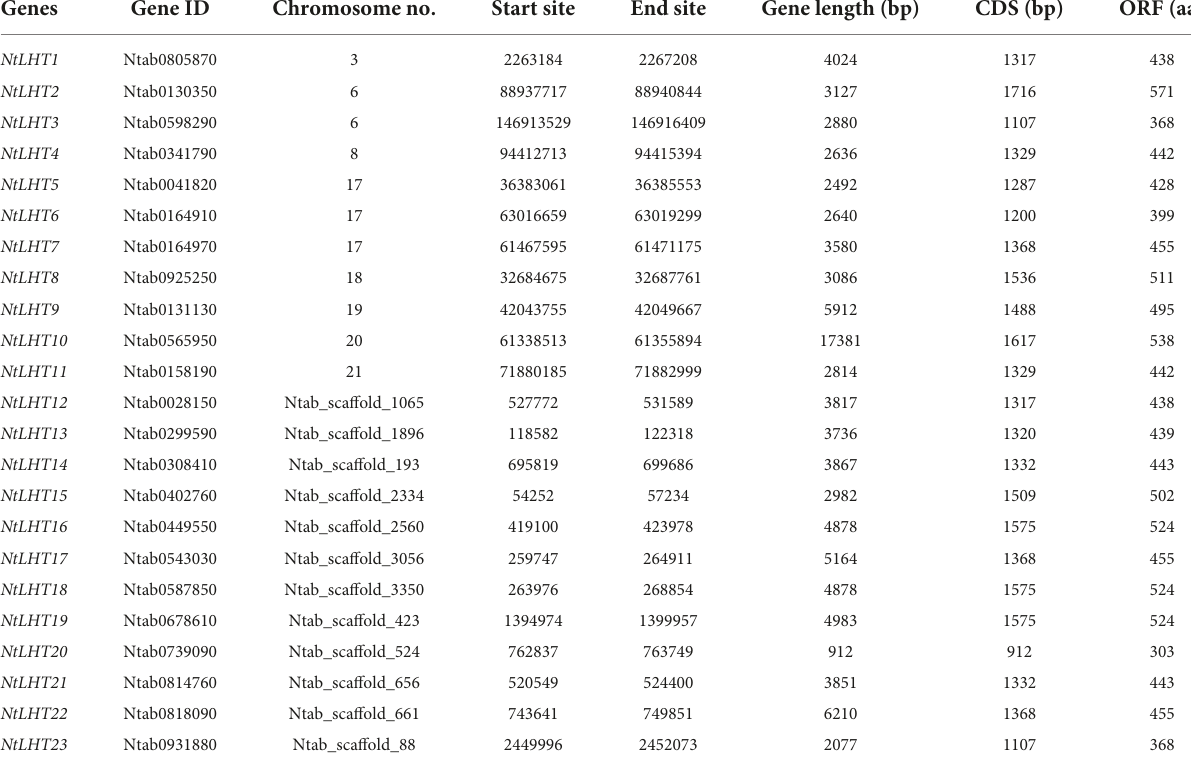
TABLE 1 Detailed information of NtLHT gene